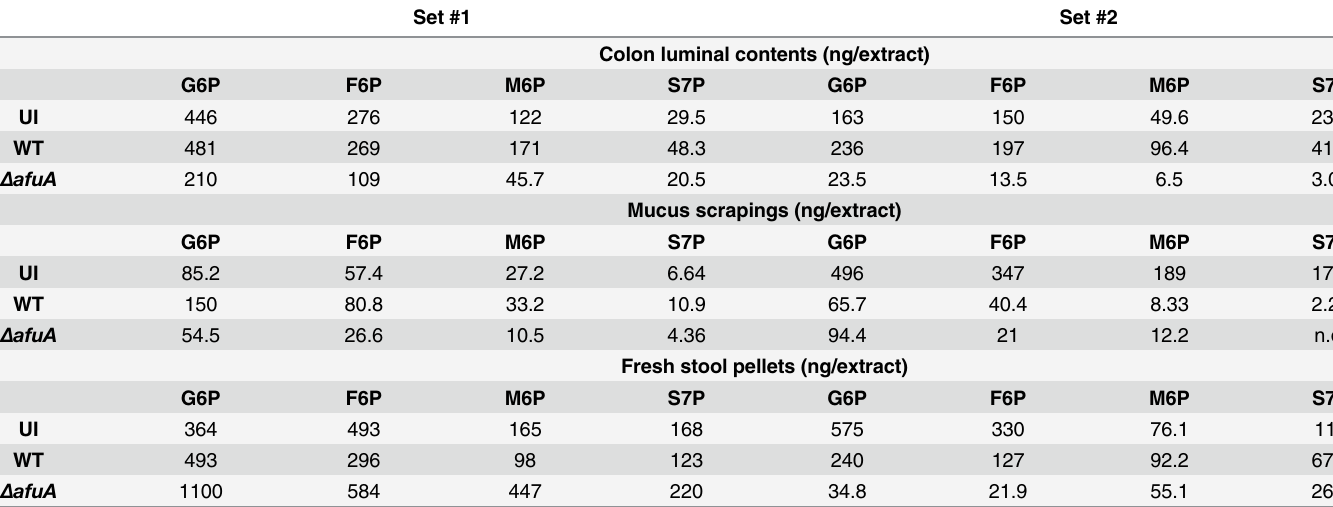
Table 3. LC-MS/MS quantification of AfuA substrates across two sets of C . rodentium -infected mice.